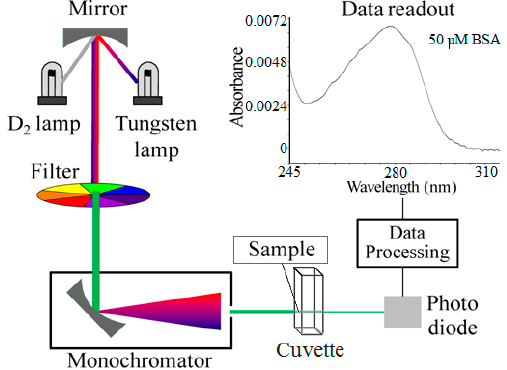
Figure 1. Measurement scheme depiction and a sample spectrum inset on the top right corner. Spectrum shows the 245–310 nm range obtained by measuring 0.5 µL of 50 µM BSA sample solution that was dried on the cuvette surface. Image is adapted from the Wiki file entitled “Schematic of UV- visible spectrophotometer”